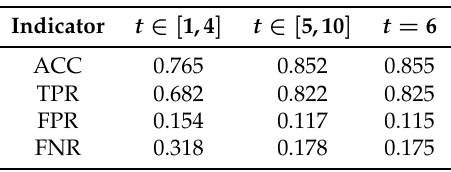
Table 3. Summary of average performance indicators of Elastic Net based on Tikhonov Regularization for different intervals of the parameter t .